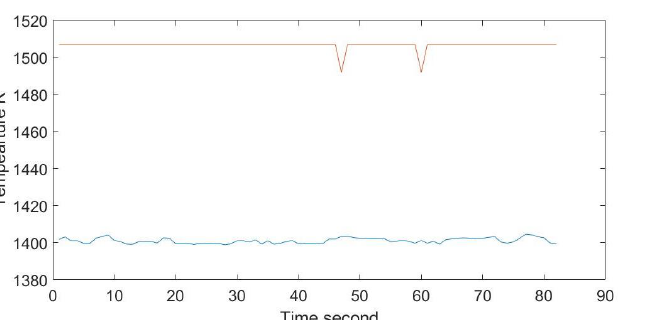
Figure 12. Two characteristic temperatures Blue: lower temperature characteristic Orange: higher temperature